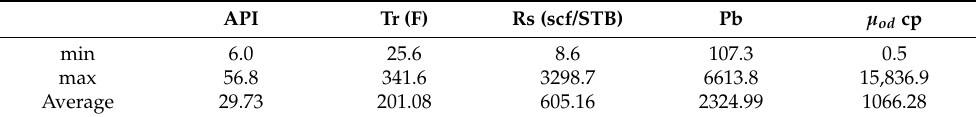
Table 2. Dataset statistical summary.